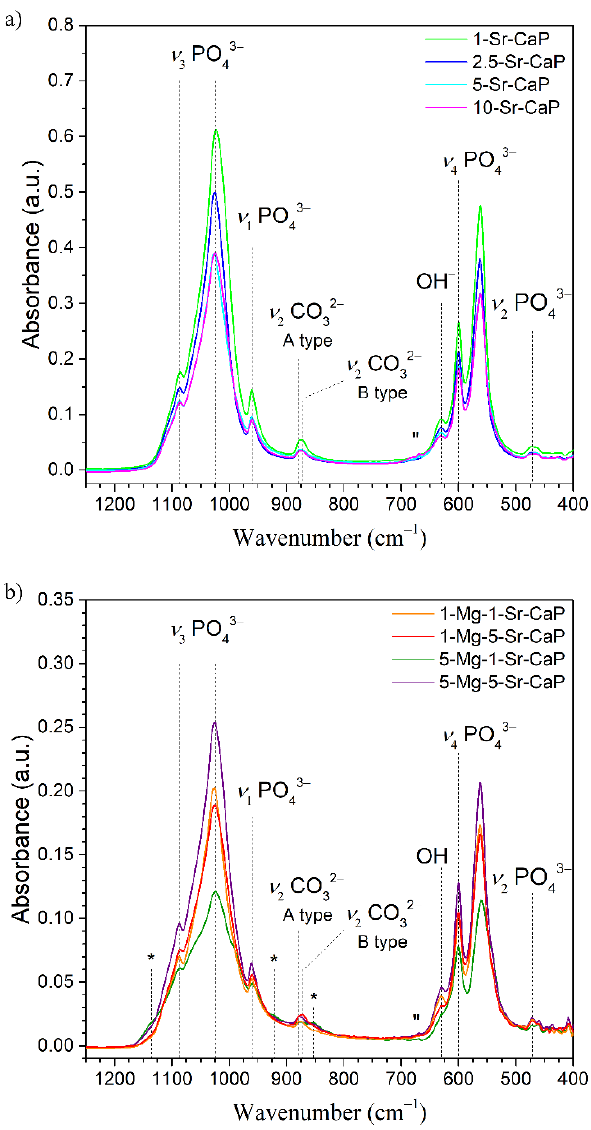
Figure 2. FTIR spectra of Sr-substituted ( a ) and Mg- and Sr-co-substituted ( b ) samples over the spectral range from 1250 to 400 cm −1 . Appearance of low-intensity vibrational bands characteristic for whitlockite are marked with * and ″.